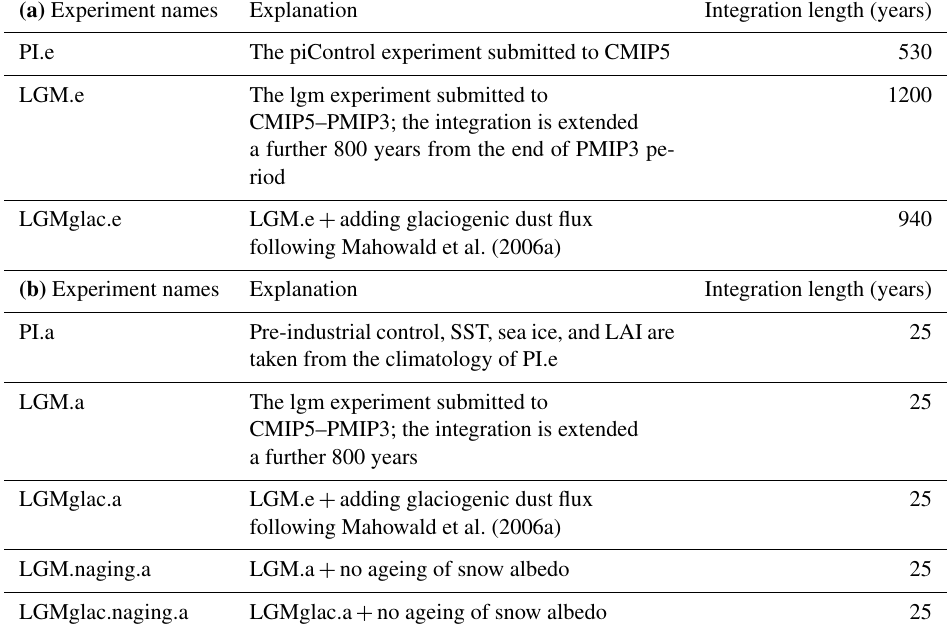
Table 2. List of experiments. (a) Experiment using MIROC-ESM. (b) Experiments using the AGCM part of